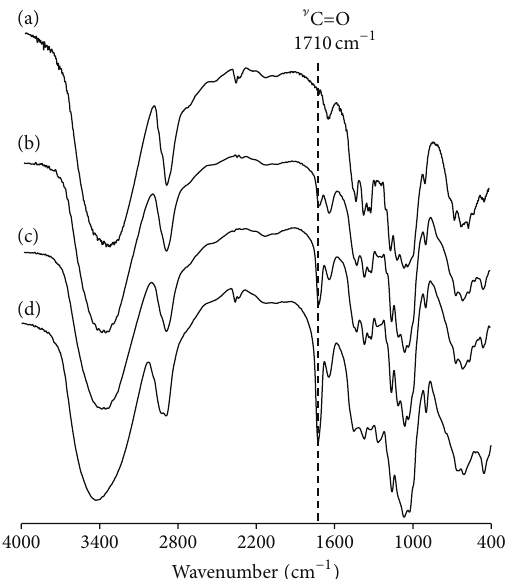
Figure 1: FT-IR spectra of the MCC-block-pHEMA produced by mechanochemical polymerization for (a) 0h, (b) 1h, (c) 3 h, and (d) 6 h. Figure 2: